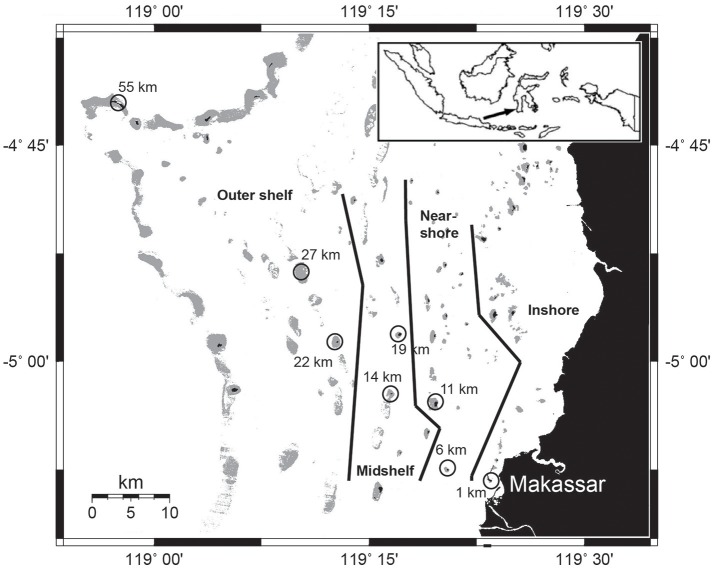
Map of the Spermonde Archipelago in southern Sulawesi. Sampling stations are circled with the according distance to Makassar. Map modified from Glaser et al. (2010), zonation modified from Renema and Troelstra (2001).